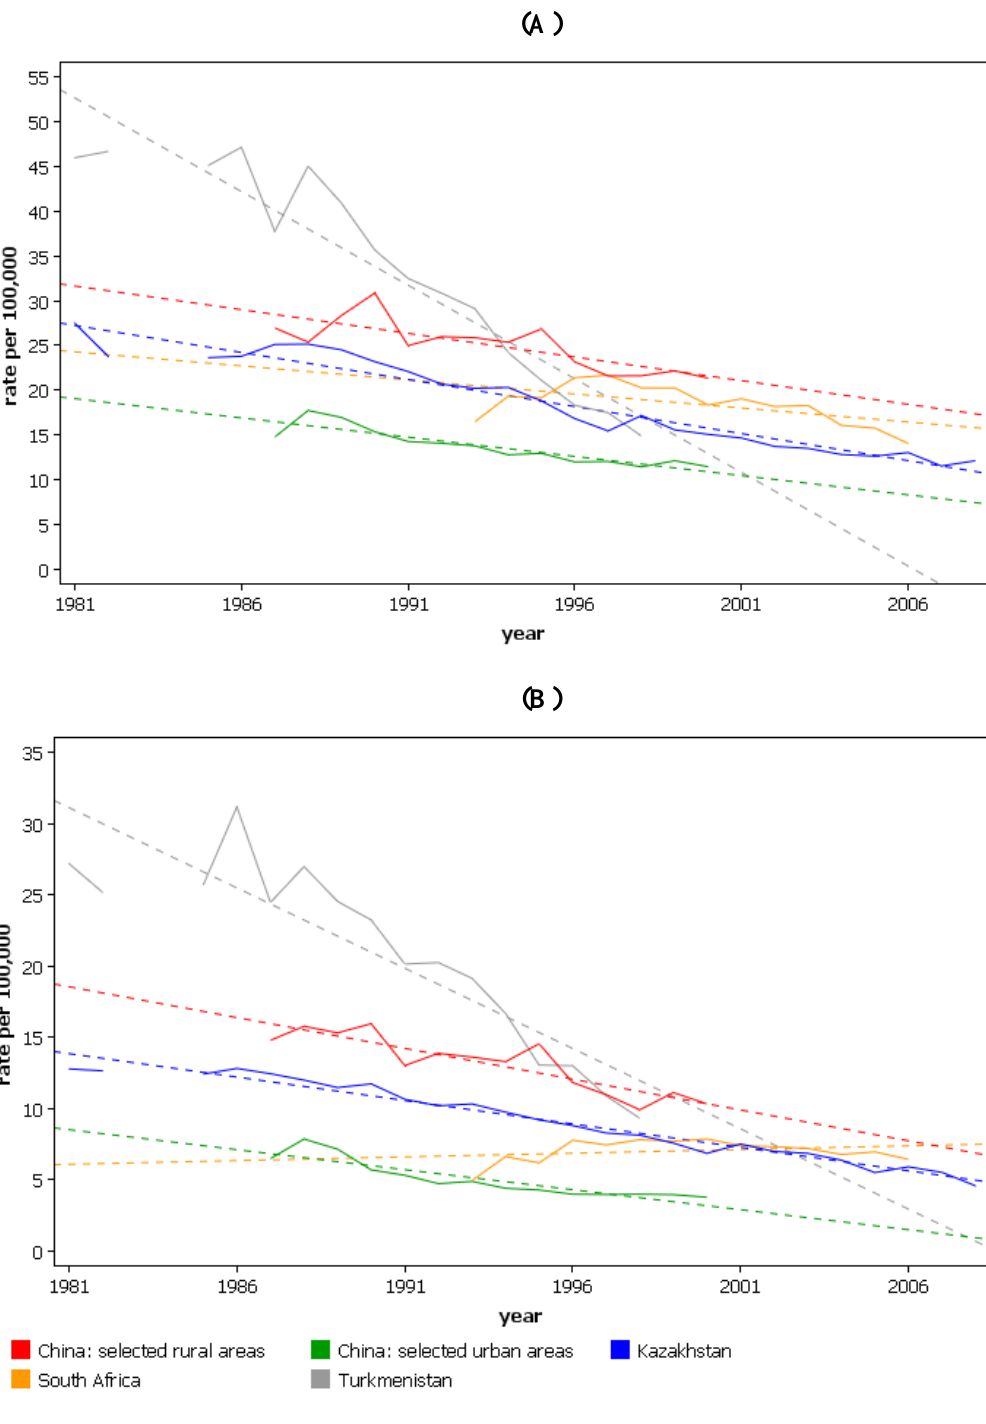
Figure 1. Mortality trends for esophageal cancer in selected countries with highest incidence, age-standardized rates (world). ( A ) males; ( B ) females. (From the WHO mortality database, International Agency for Research on